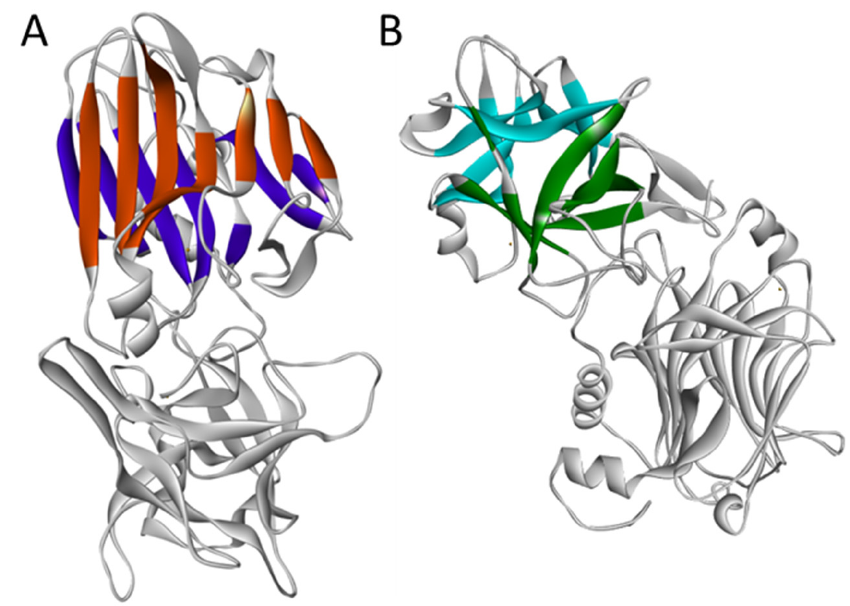
Figure 2. TTFC jelly roll ( A ) and β -trefoil ( B ) domains. ( A ): in dark orange, concave solvent-exposed face; in dark purple, convex solvent-exposed face. ( B ): in blue, β -hairpin triplet; in green, β -barrel.